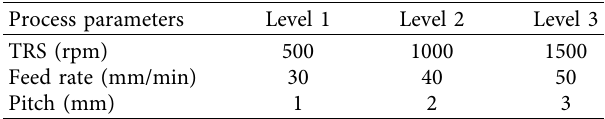
Figure 2: ASTM standard specimen dimensions for UTS. Table 1: Input process